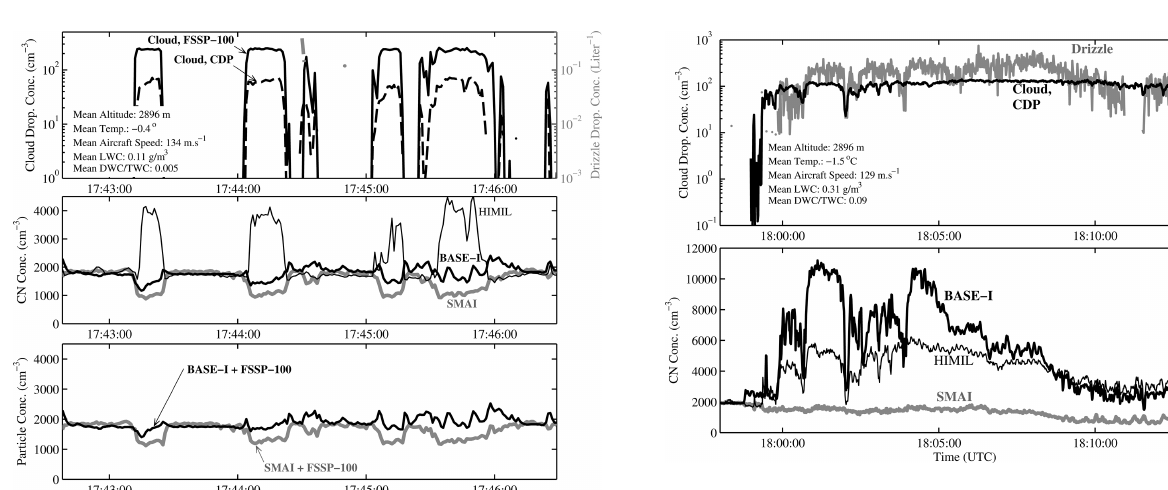
Figure 4. Performance of three aerosol inlets on the C-130 aircraft during a cloud penetration in the presence of drizzle. Data from PLOWSff03 (3 November 2009)